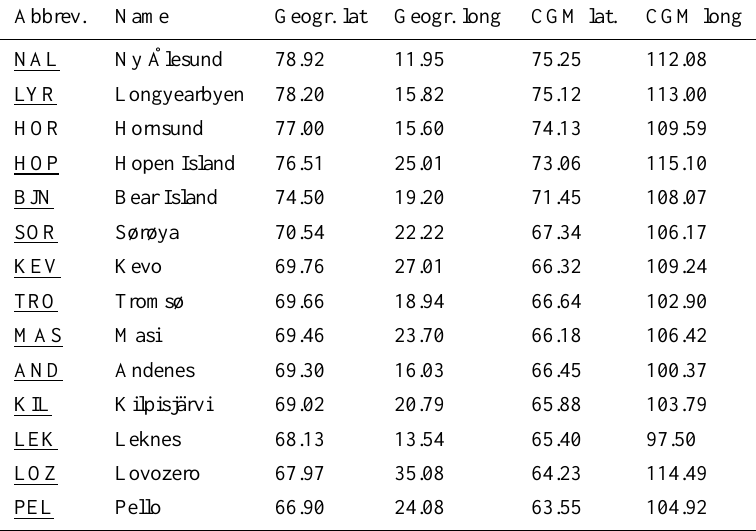
Table 1. Geographical and CGM coordinates of IMAGE stations.